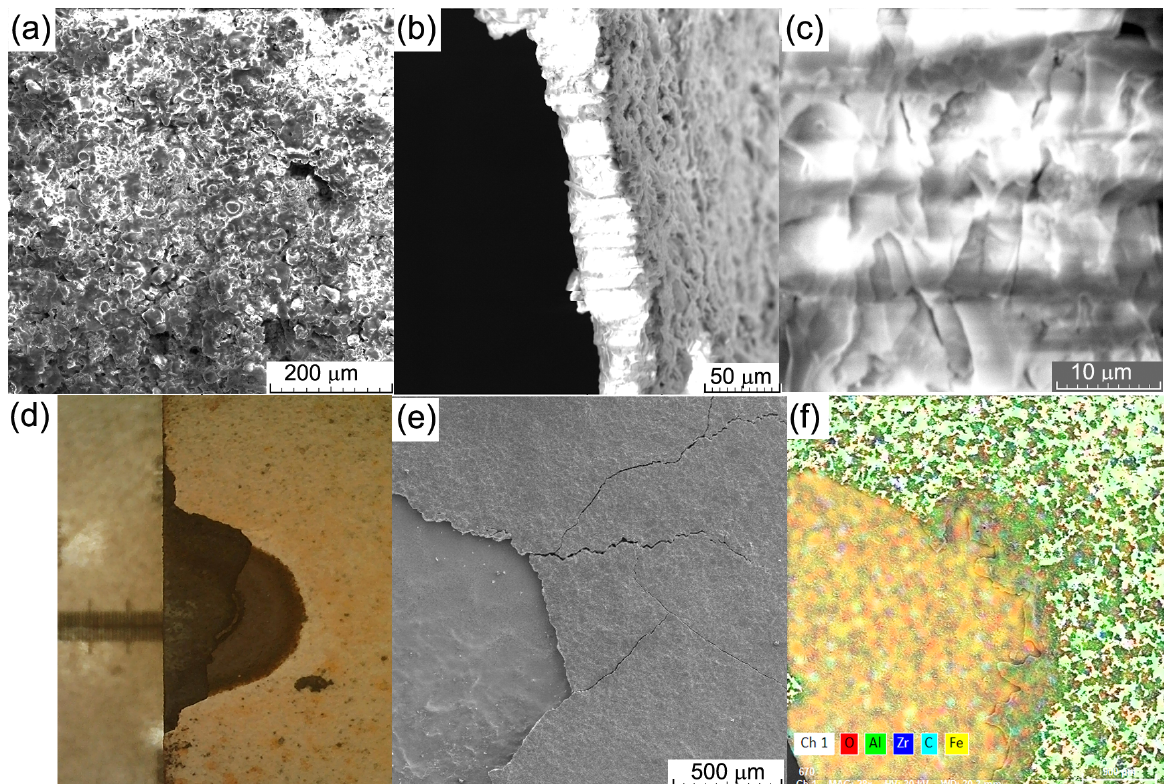
Figure 3. Ceramic layer after the detachment from the substrate with a transversal view and a detail of the plate structure. ( a ) SEM image of ceramic layer; ( b ) transversal view of the ceramic layer, 500×; ( c ) transversal view of the ceramic layer, 3500×; ( d ) optical image of the exfoliation area, ( e ) SEM image of the cracks growth on the ceramic layer and ( f ) element distribution on the damage area.